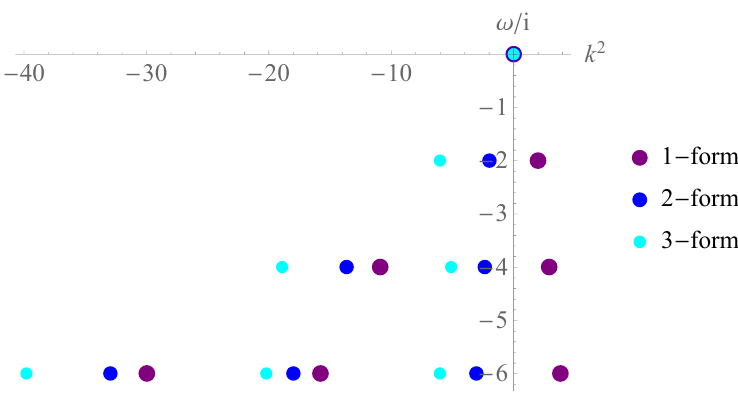
Figure 1 . Scatter diagram for the massless longitudinal mode. The background spacetime is set as AdS ( d = 3) ; the radius is fixed as r 5